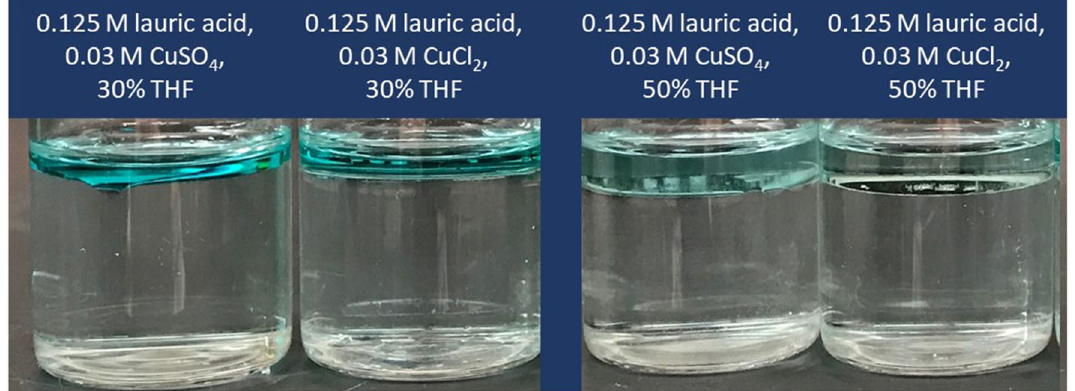
Figure 6. Bottle tests conducted using aqueous solutions of 0.03 M CuCl 2 and CuSO 4 , using 30% or 50% THF v/v relative to water, at circum-neutral pH. Copper ions partition in the THF phase only at circum-neutral, while they remain solubilized in water at pH = 2 and precipitate in part out of solution at pH = 13 (Fig. S10, supporting information file). Images were taken after leaving vials to sit overnight.